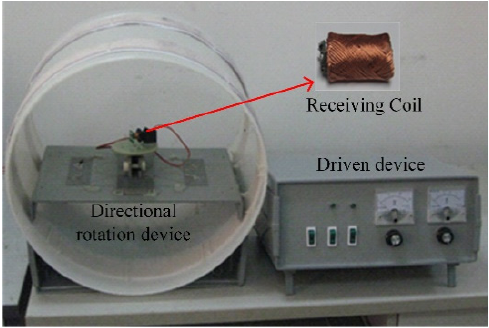
Figure 5. The Setup for measuring mutual inductance when the receiving coil is in different directions.